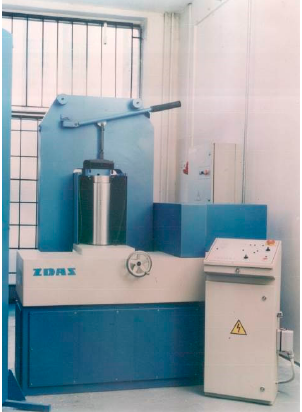
Figure 1. Photography of a high-pressure press CYX 6/0103 (own elaboration).